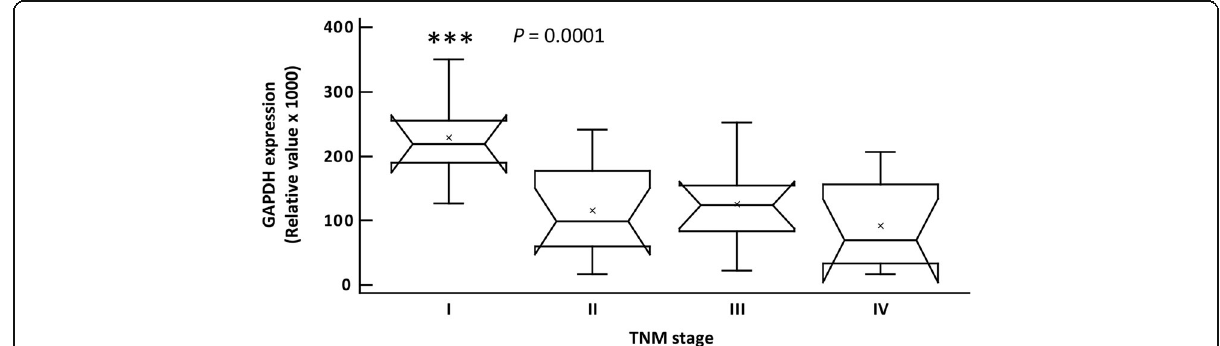
Fig. 2 GAPDH expression in relation to tumour stage. Box and whiskers plot illustrates GAPDH overexpression observed in stage I primary tumours. Mean values are represented by a cross and median values by a horizontal line in each